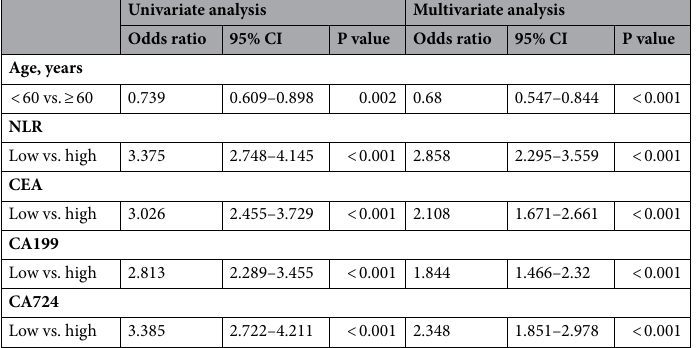
Table 4. Univariate and multivariate binary logistic regression analyses of variables for GC metastasis. The reference of age, NLR, CEA, CA19-9 and CA72-4 was age < 60, NLR < 2.91, CEA < 4.34, CA19-9 < 18.69 and CA72-4 < 6.96.